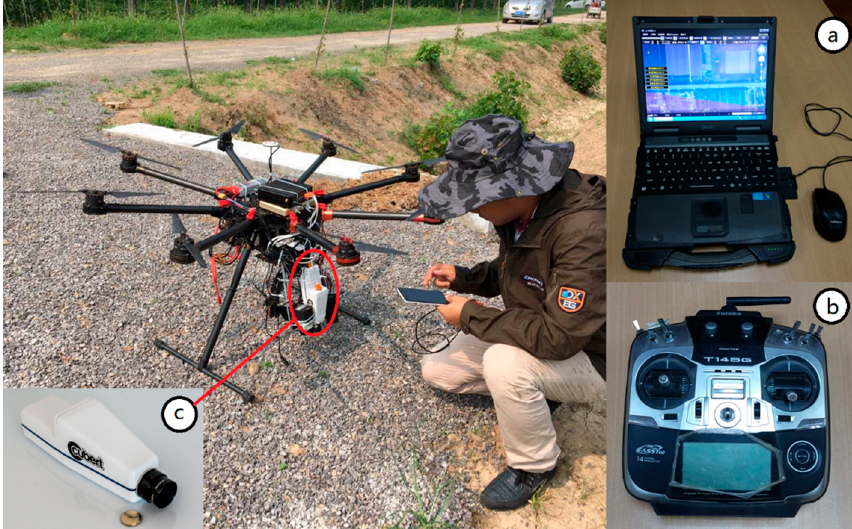
Figure 3. Components of the UHD 185 hyperspectral system: ( a ) reinforcement notebook computer and ground control station; ( b ) remote controller; ( c ) UHD 185 Firefly spectrometer.